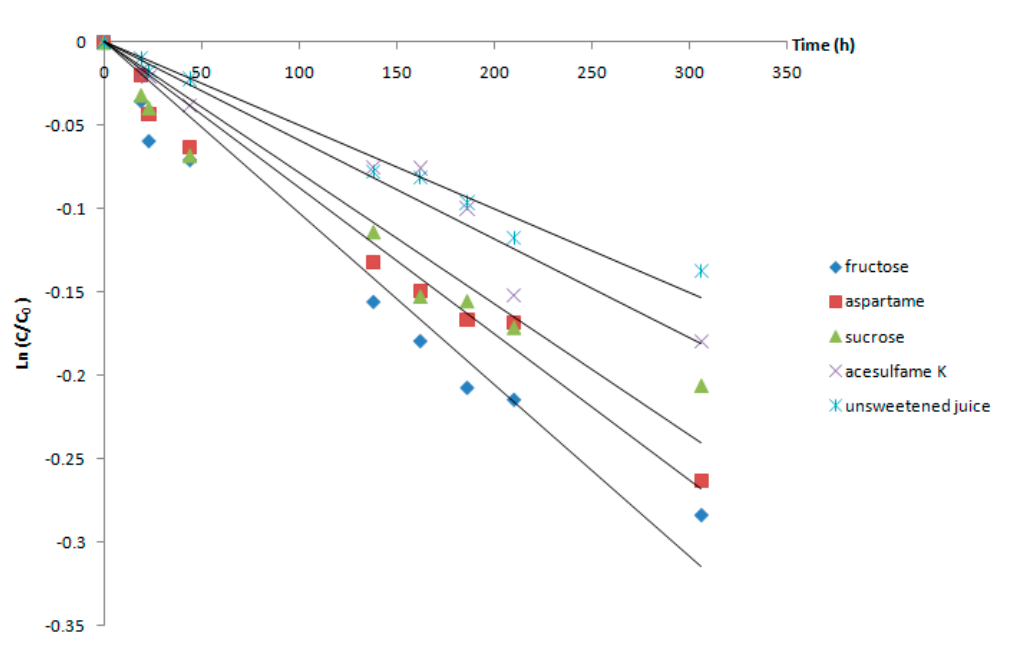
Figure 2. Degradation of the anthocyanins from Cornelian cherry fruit juice at 2 °C.